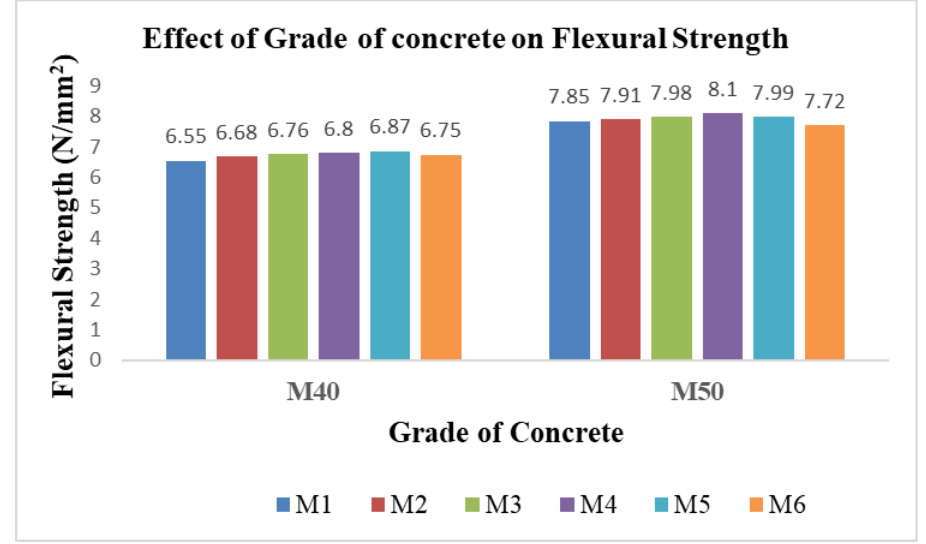
Figure 9. Comparison of the flexure strengths of various specimens of different grades.